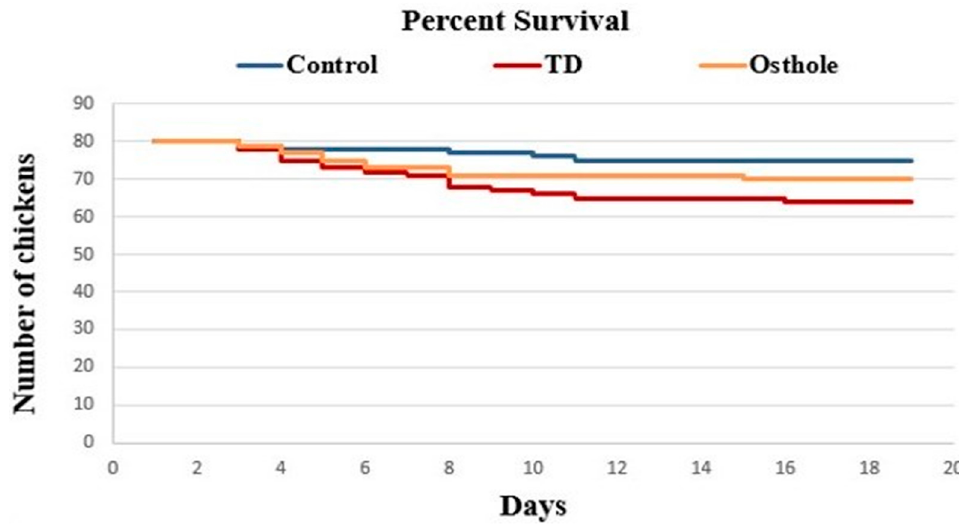
Figure 4. Effect of osthole on the survival rate of chickens. The osthole group chickens that were initially challenged with thiram from days 4–7 were treated with osthole from days 8 to 18.